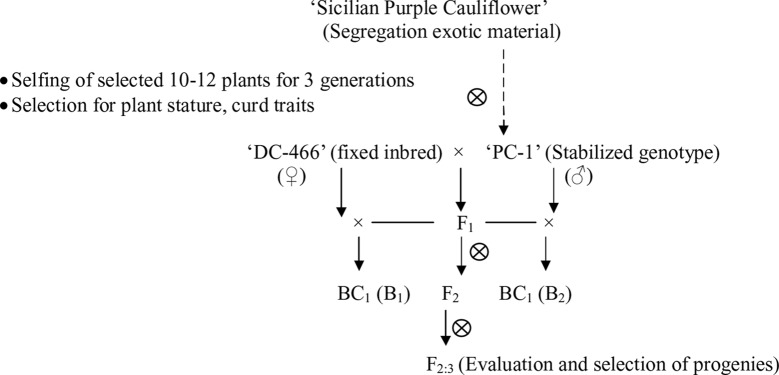
Population development procedure used in the study.